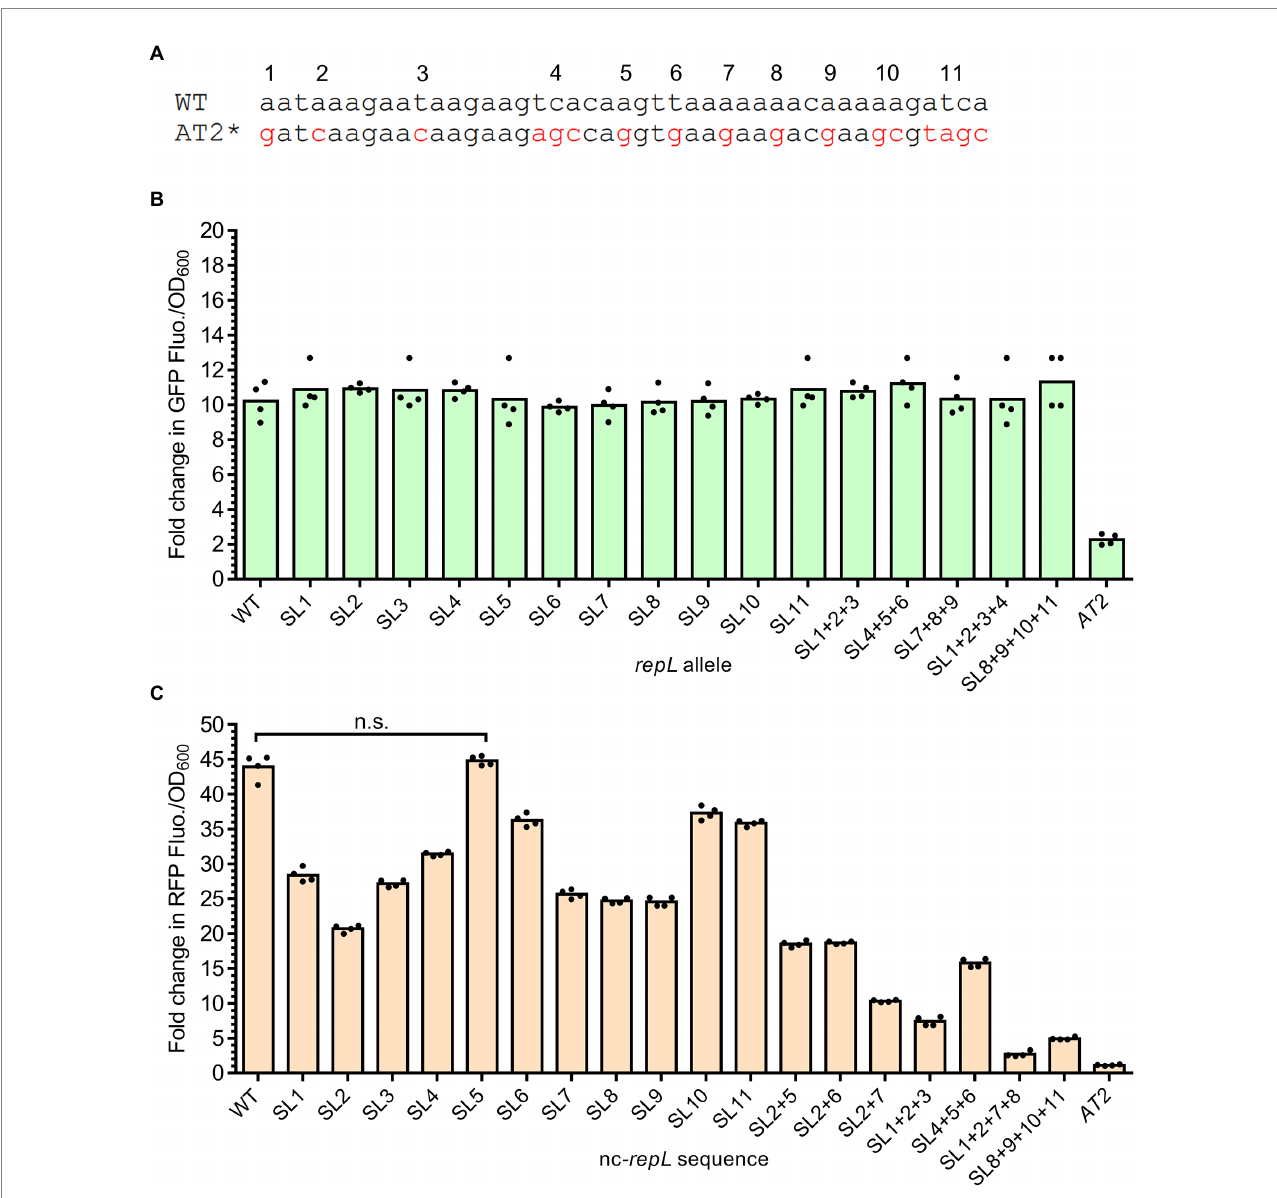
FIGURE 6 Base substitution at single or combination of positions within the AT2 region of a nc- repL sequence produced varying levels of RepL-mediated RFP signal amplification. (A) Schematic diagram showing the differences in DNA bases between wildtype (WT) and repL AT2 (AT2*) sequences. Characters in red represent DNA base(s) which were substituted, and the mutations were numbered from 1 to 11 based on their position within the AT2 region. Base substitution at a single position would be named as “SL (position of nucleotide substitution),” while combinations of mutations would be named as “SL (position of nucleotide substitution) + (position of nucleotide substitution).” A repL AT2 allele or a nc- repL AT2 sequence contain base substitutions at all of the 11 positions. (B) Fold change in GFP fluorescence intensity per OD 600 of TOP10 cells (GFP FIuo./OD 600 ) transformed with a SL gfp.repL , gfp.repL AT2 ( AT2 ) or gfp. repL WT (WT) plasmid at 10 hpi with 1.33 × 10 − 4 M of L-arabinose. Fold changes in the GFP FIuo./OD 600 were calculated based on comparison between arabinose-induced and uninduced state. All GFP fluorescence intensity values were normalized to that of TOP10 cells transformed with an empty plasmid without gfp and repL genes. Comparisons of the fold changes in GFP Fluo./OD 600 values between WT and all SL repL alleles with Welch’s ANOVA yielded a value of p of 0.7654, indicating no significant differences in the GFP output level between different samples. (C) Quantification of the fold change in RFP fluorescence intensity per OD 600 of TOP10 cells (RFP FIuo./OD 600 ) co-transformed with a gfp.repL AT2 plasmid and a SL rfp. nc -repL , rfp. nc -repL AT2 ( AT2 ) or rfp. nc- repL WT (WT) plasmid at 10 hpi with 1.33 × 10 − 4 M of L-arabinose. Fold changes in RFP Fluo./OD 600 were calculated based on comparison between arabinose-induced and uninduced state. Comparisons in the fold changes in RFP Fluo./OD 600 values between WT and all SL nc- repL constructs with Welch’s ANOVA yielded a value of p of 0.028, indicating significant differences in the RFP output level between different samples. n.s. represented no significant difference(s) in the RFP Fluo./OD 600 values between WT and SL5 nc- repL constructs ( p > 0.05). All RFP fluorescence intensity values were normalized to that of TOP10 cells transformed with empty plasmids without rfp gene and nc- repL sequence. The induction assay was performed with 4 biological repeats, with each data point represented the average value of 3 biological replicates. Data were presented as mean ±